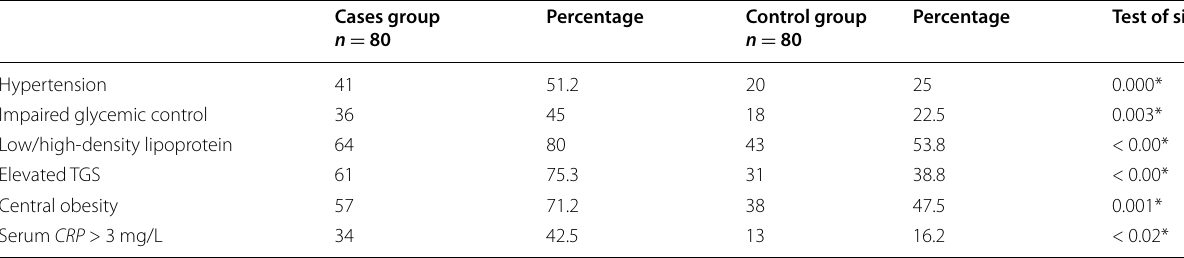
*Statistically significant if p < 0.05